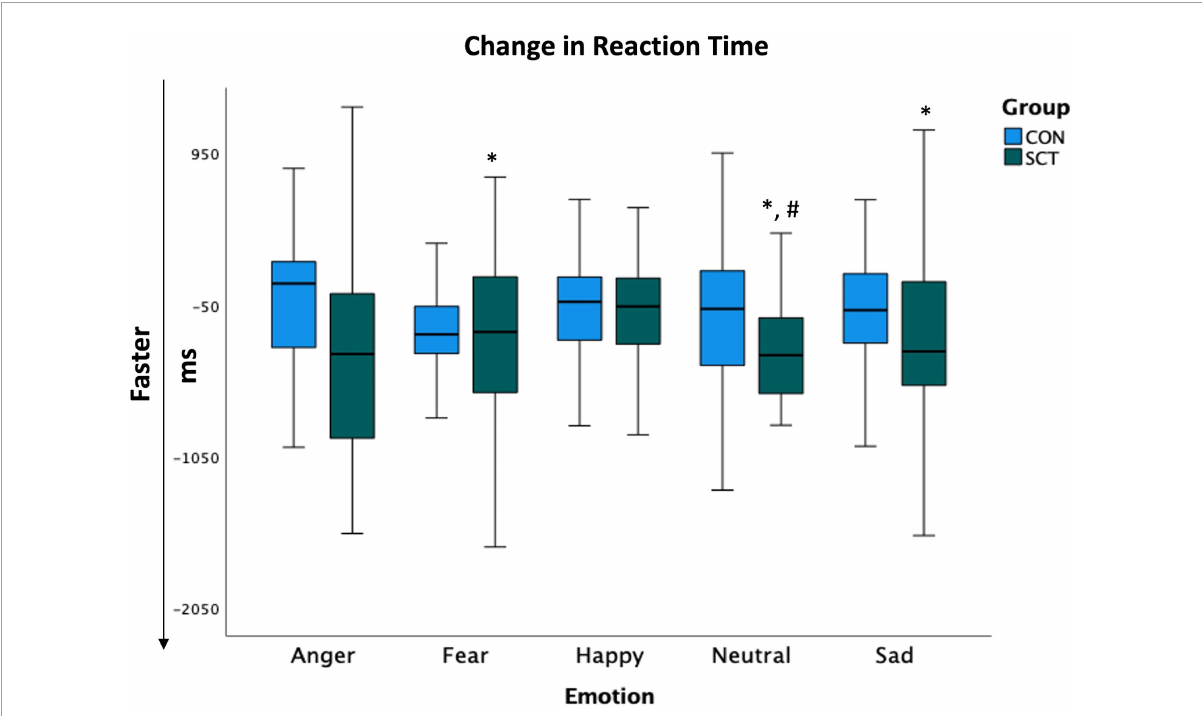
FIGURE3 Change in reaction times (post-intervention minus pre-intervention). Larger negative values indicate greater improvement. ∗ Indicates significant change from pre- to post-intervention ( p < 0.05). # Indicates significant difference between